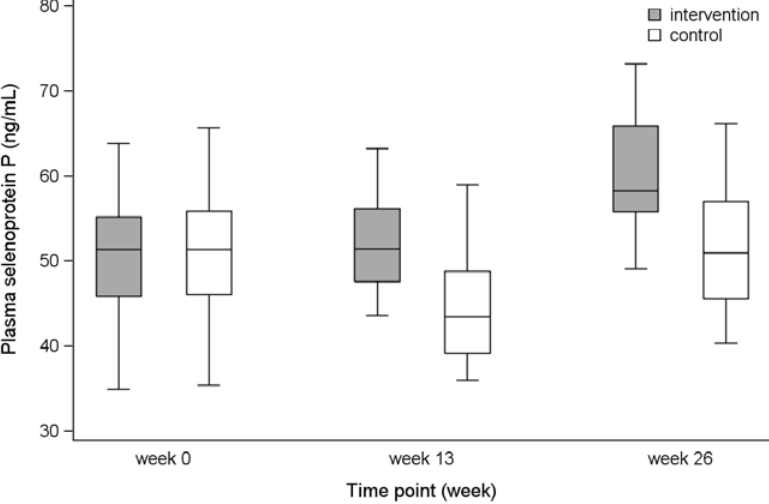
Figure 3. Plasma selenoprotein P concentrations for the intervention and the control group presented as 5th, 25th, 50th, 75th and 95th percentiles for Weeks 0, 13, and